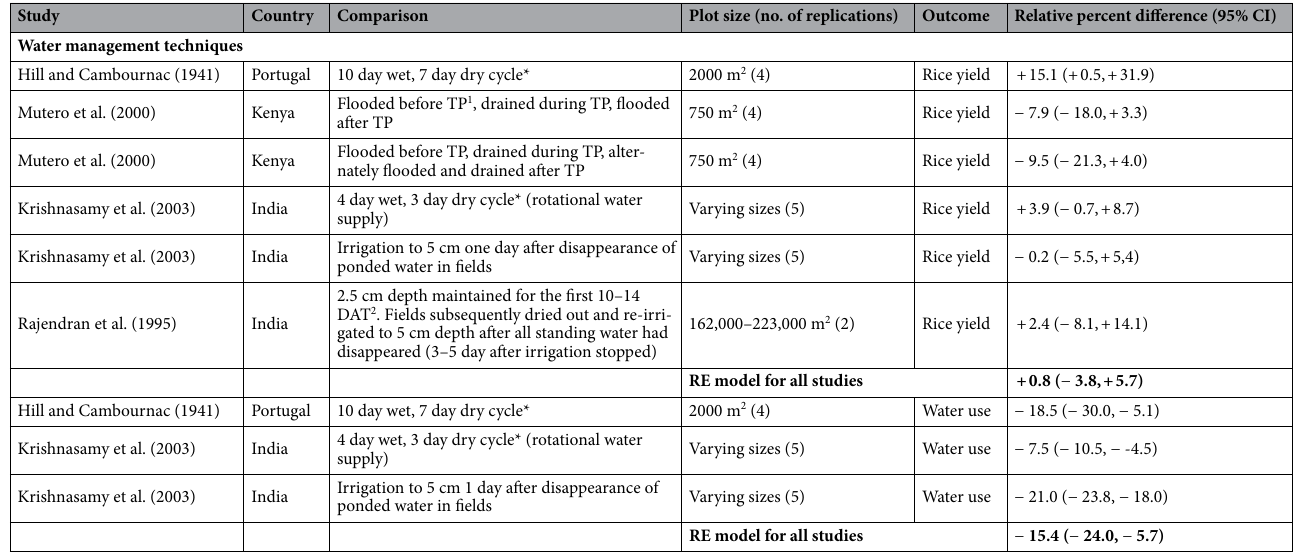
Table 4. Summary of findings of meta-analyses of the association between different types of rice cultivation practices and agronomic outcomes. Significant values are in bold. *Water is applied to the field so that it is wet for X days and left for X days to dry before being irrigated again. 1 TP: Transplanting. 2 DAT: Days after